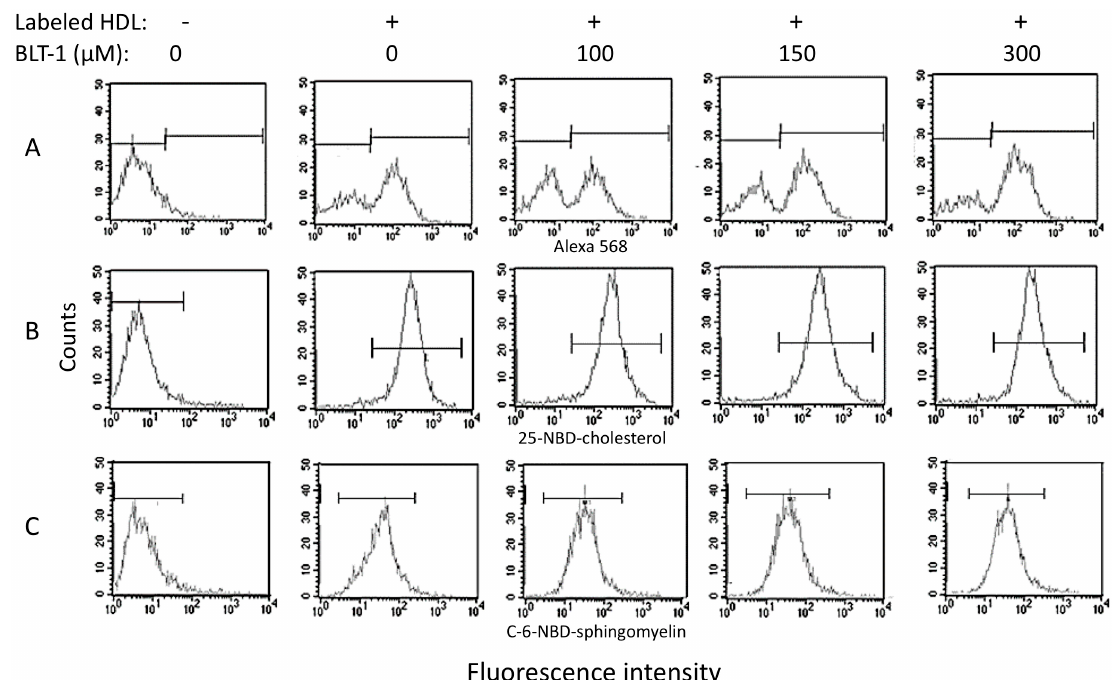
Figure 4. Contribution of scavenger receptor class B type I (SR-BI) to the uptake of different components of rHDL by HMEC-1 as determined by flow cytometry. Cells were incubated with single-labeled rHDL containing ( A ) Alexa-488-labeled apo AI, ( B ) 25-NBD-cholesterol, ( C ) C-6-NBD-sphingomyelin; different concentrations of block lipid transport-1 (BLT-1) are indicated at the top of the figure. Representative graphs of the number of events (counts, vertical axis) vs. fluorescence intensity (horizontal axis) are shown. Horizontal bars indicate the regions corresponding to cells that incorporated the fluorescent tracer (right bars) and nonlabeled cells (left bars). For C-6-sphingomyelin, labeled and nonlabeled cells overlapped in the experiments that included BLT-1.